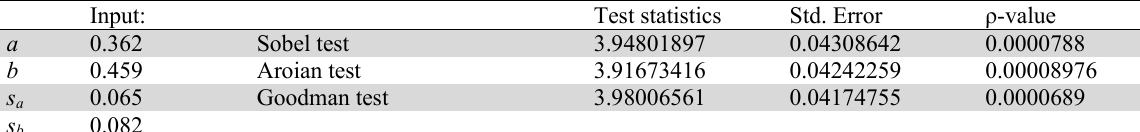
Sobel test results for destination image, E-wom and re-visit intention